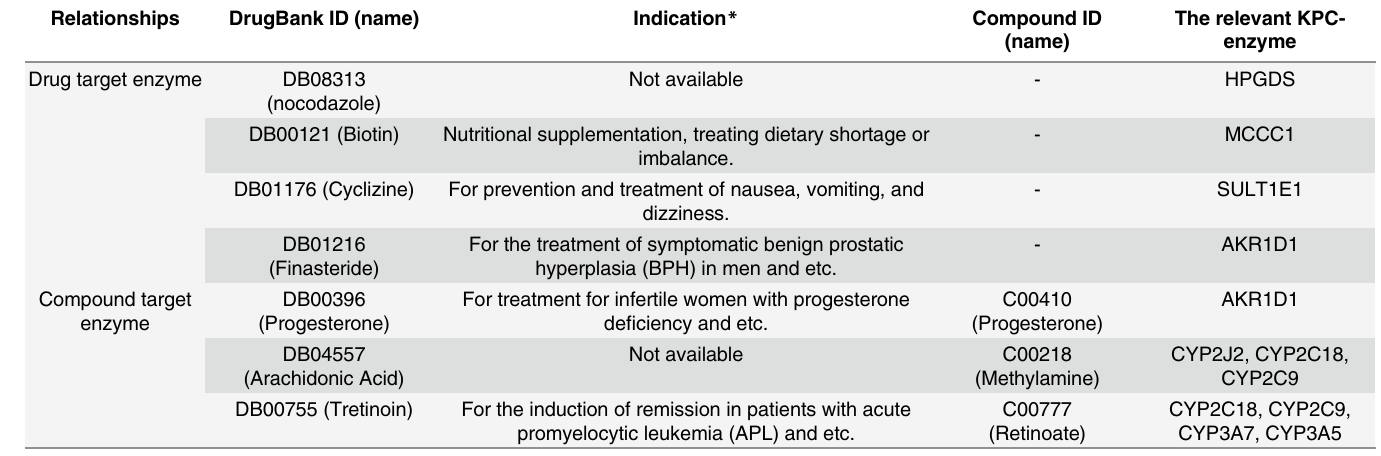
Table 2. Predicted candidate drugs for treating pancreatic cancer. Relationships